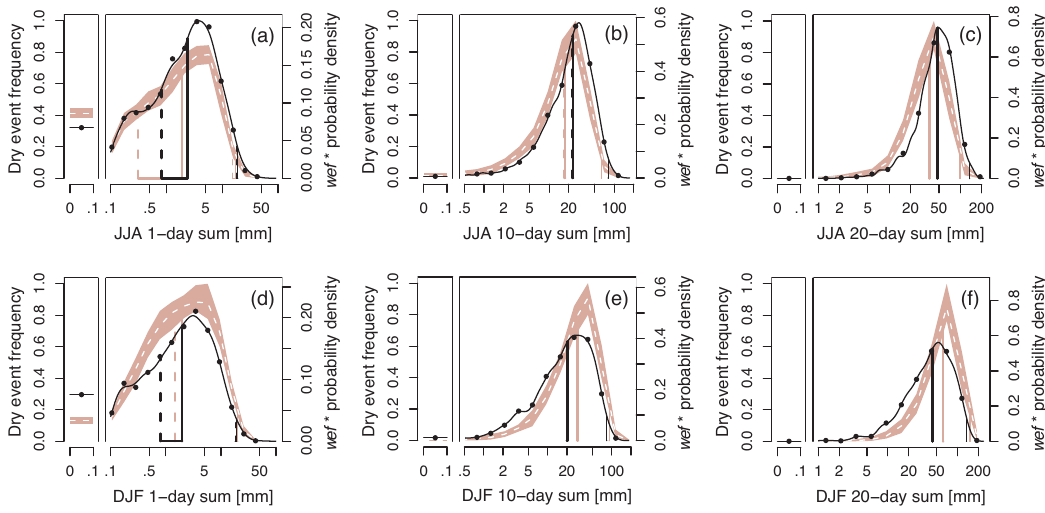
Fig. 2. Validation of ESSENCE against CHR-OBS: PDFs for the North Rhine region during the control period (1961/1962–1990/1991), in JJA (top row) and in DJF (lower row) for 1-, 10- and 20-day precipitation sums (left-right). The color shading envelops the 95% range of the probability density attained from individual ensemble members, dashed white shows the mean. Black dots show CHR-OBS binned observations and the black curve is an empirical fit (kernel density estimate using Gaussian smoothing) giving the CHR-OBS probability density. The frequency of dry events (separate column, left of each PDF) plus the integrated PDF of wet events (scaled by the wet event frequency, wef) together sum to unity. Vertical lines mark the locations of the 50% (thick) and 99% (thin) quantiles for the intensity PDF (solid) and the full distribution that includes the dry events (dashed). Note that the counting measure used for binning is the logarithm of the precipitation sum.